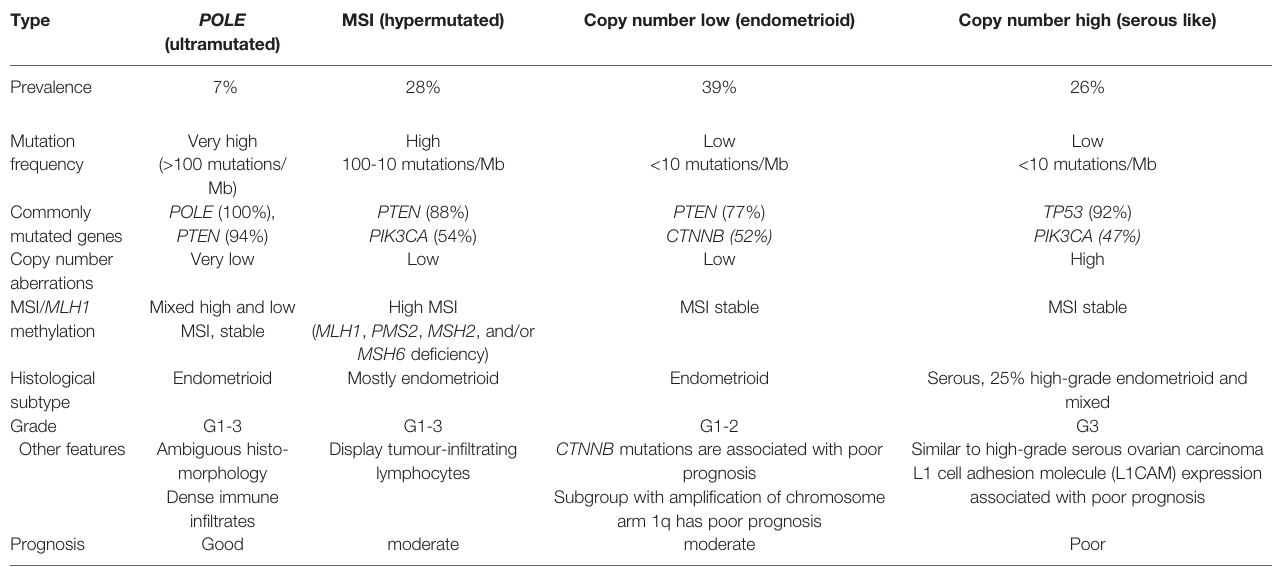
TABLE 3 | Characteristics of the TCGA molecular classi fi cation of endometrial cancer.